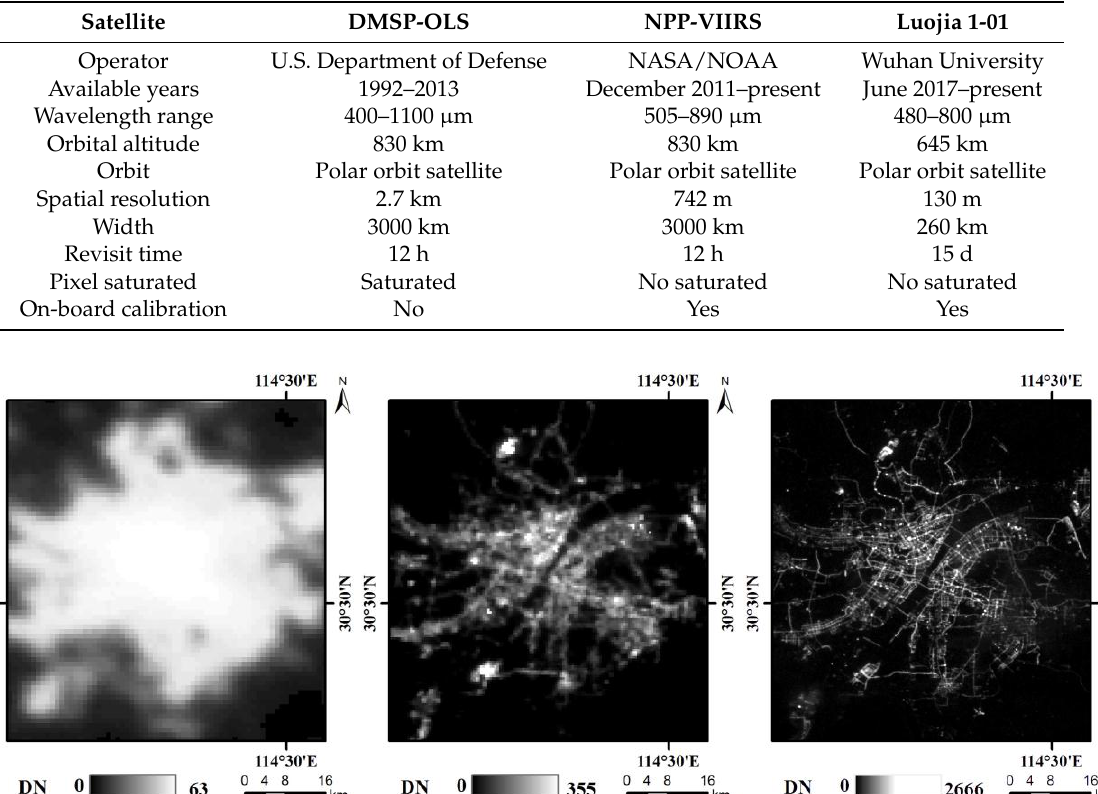
Table 1. The parameter comparisons of Defense Meteorological Satellite Program Operational Linescan System (DMSP-OLS), the Suomi National Polar-Orbiting Partnership Visible Infrared Imaging Radiometer Suite (NPP-VIIRS), and Luojia 1-01.